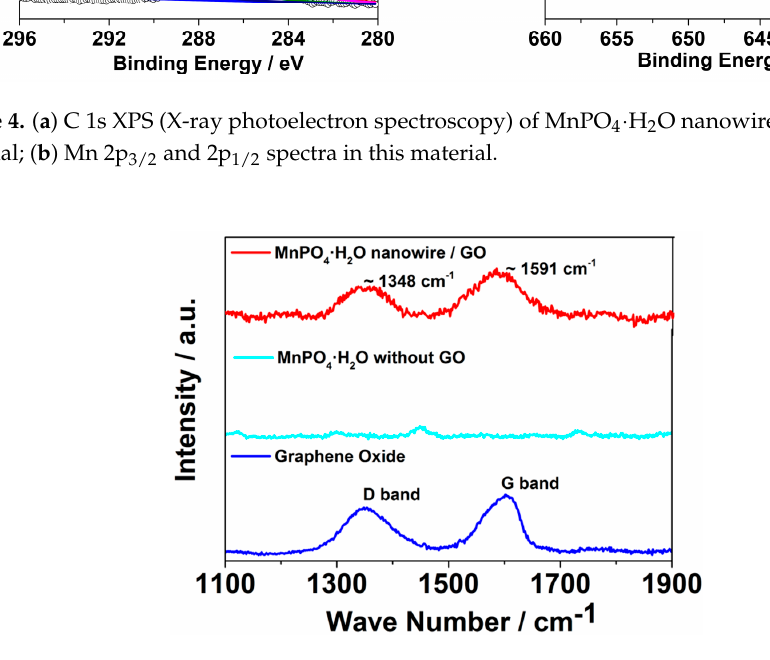
Figure 5. Raman spectra of MnPO 4 · H 2 O nanowire/GO composite, as-prepared MnPO 4 · H 2 O sample without GO and GO